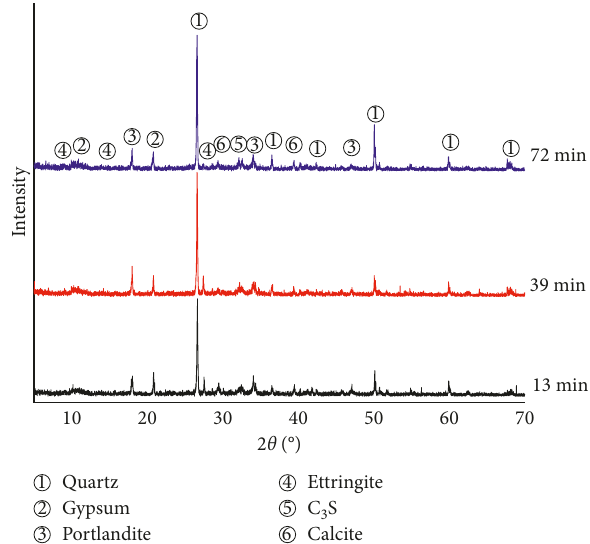
Figure 5: Compressive strength of the mortars with different grinding times.